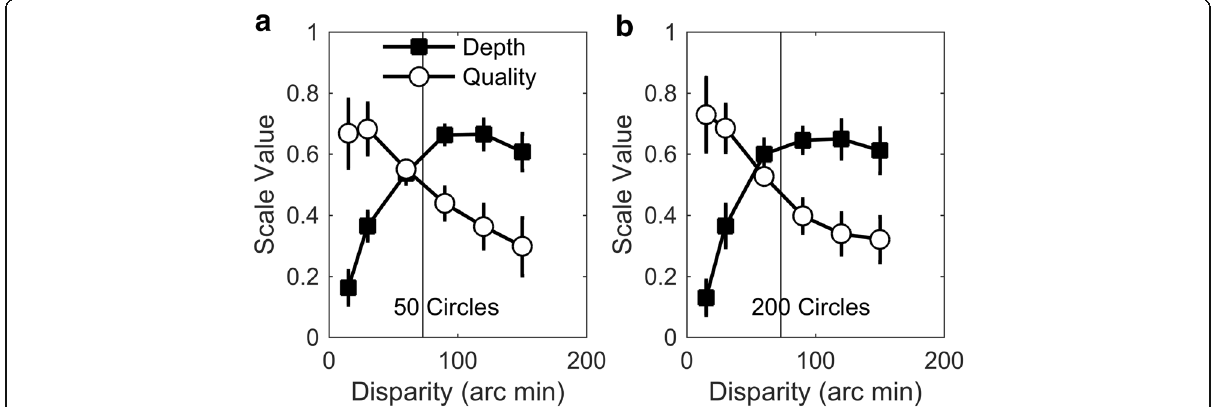
Fig. 2 Mean depth magnitude and quality judgments for stimuli with ( a ) 50 and ( b ) 200 circles . The vertical line shows the mean point at which 50% of stimuli were seen as fused (as detailed in experiment 4). Error bars show ±1 standard